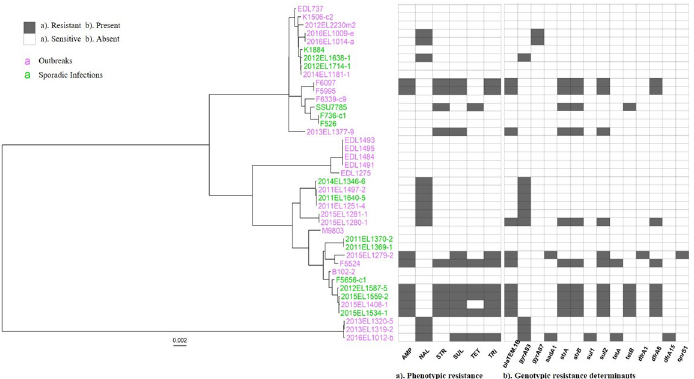
Fig 3. Heat map visualization of phenotypic and genotypic antimicrobial resistance patterns of ETEC O6 isolates. Phenotypic antimicrobial resistance and resistance determinants were visualized alongside WG-hqSNP phylogeny using the ggtree package in R. a). Phenotypic antimicrobial resistance patterns: AMP: Ampicillin; NAL: Nalidixic acid; STR: Streptomycin; SUL: Sulfisoxazole; TET: Tetracycline; TRI: trimethoprim-sulfamethoxazole. b).